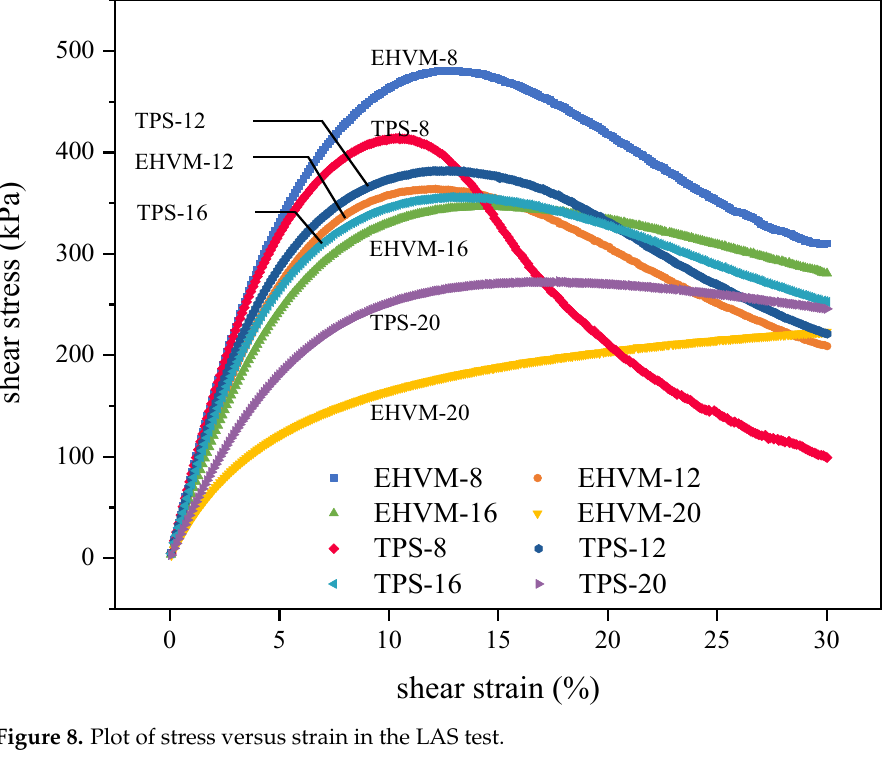
Figure 8. Plot of stress versus strain in the LAS test.